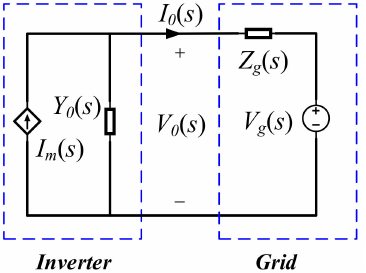
Figure 3. Equivalent circuit of the SCGCS.